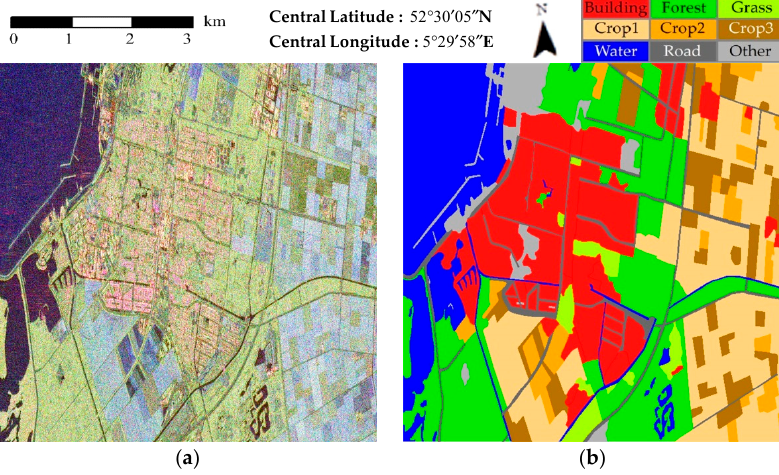
Figure 3. C-band, single-look RADARSAT-2 PolSAR image in Flevoland as the second data set: ( a ) Pauli RGB image and ( b ) the ground truth map of ( a ).